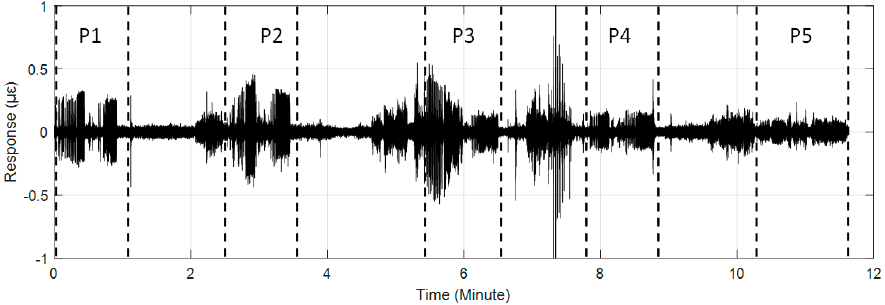
Figure 7. Distributed structural vibration of #159 zone of the track bed under multiple position perturbations.